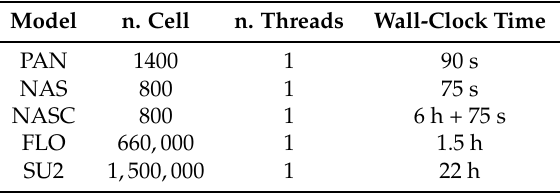
Table 10. Mesh size and computational time required by the different models for the Embraer Benchmark Wing